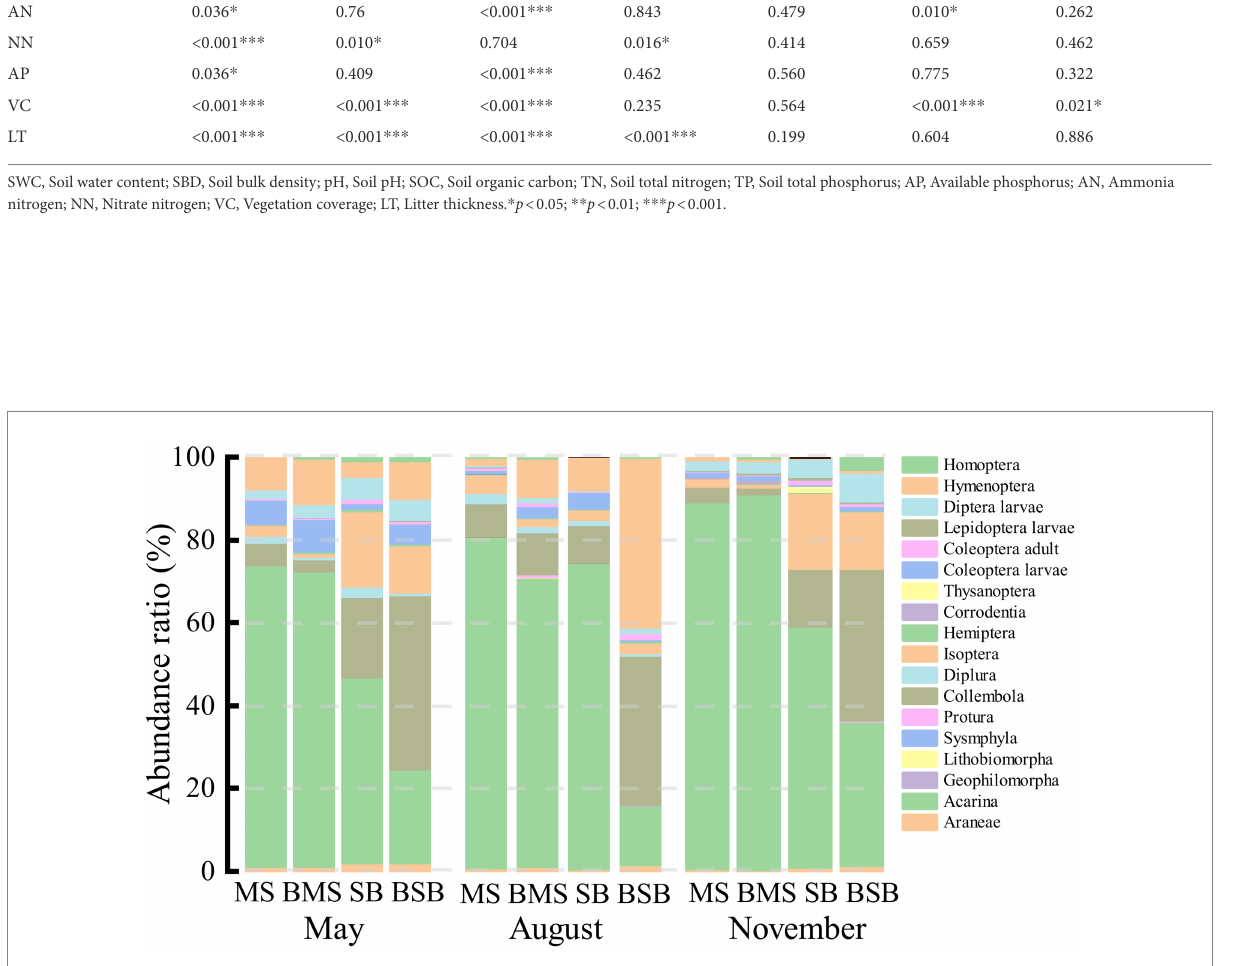
FIGURE 3 The proportion of a certain group abundance to the total group abundance in May, August, and November. SB, Stipa bungeana habitat; BSB, Burned Stipa bungeana habitat; MS, Medicago sativa habitat; BMS, Burned Medicago sativa